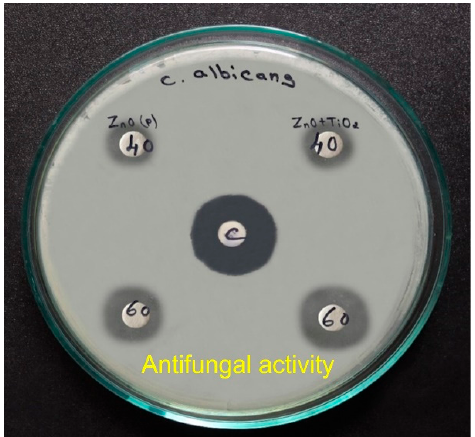
Figure 14. Antifungal activity of pure ZnO and ZnO-doped TiO 2 NPs against Candida albicans stains.